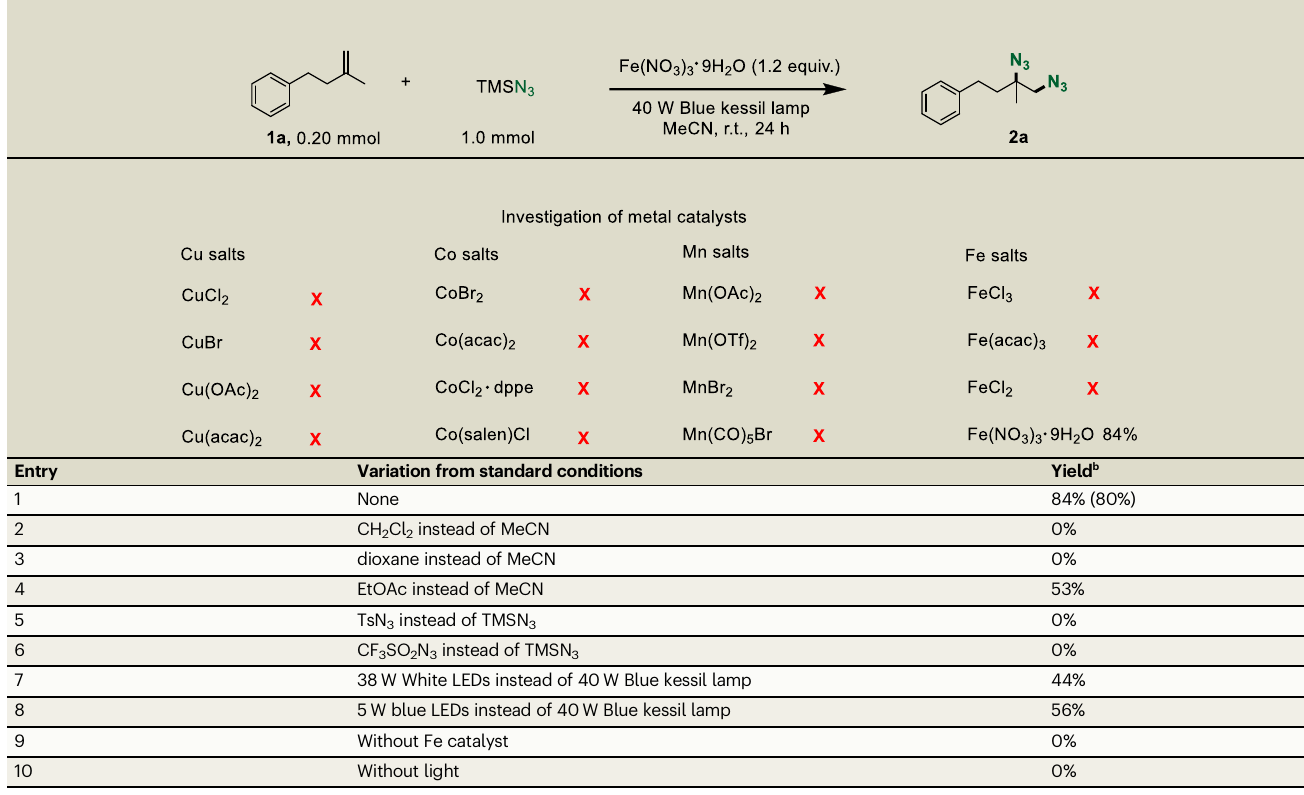
Table 1 | Optimization of reaction conditions